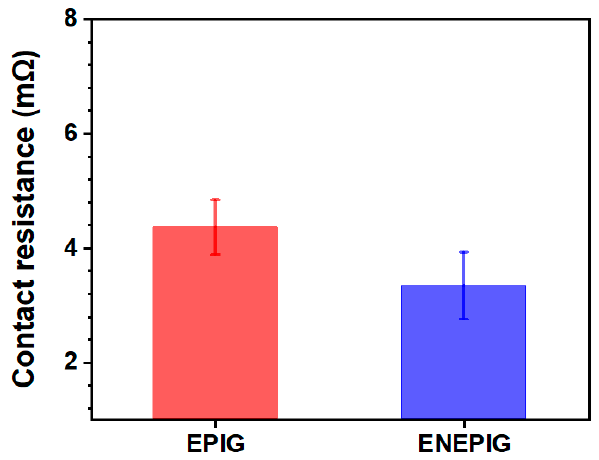
Figure 11. Contact resistance of Cu/SnAg pillar bump joints on surface finishes, EPIG and ENE- PIG.